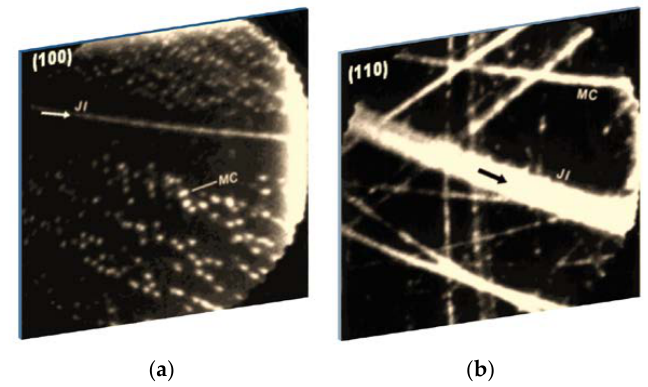
Figure 58. 18 O images at a depth of 1 μm in ( a ) (100) and ( b ) (110) bicrystals annealed at 1325 K for 1800 s. JI and MC indicate the joining interface and mechanical damage. The integration time of 18 O is 300 s. The size of 18 O images is 100 mm. Adapted from [259].